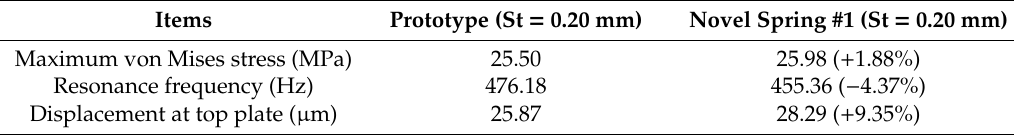
Table 7. Analysis result comparison between prototype spring and novel